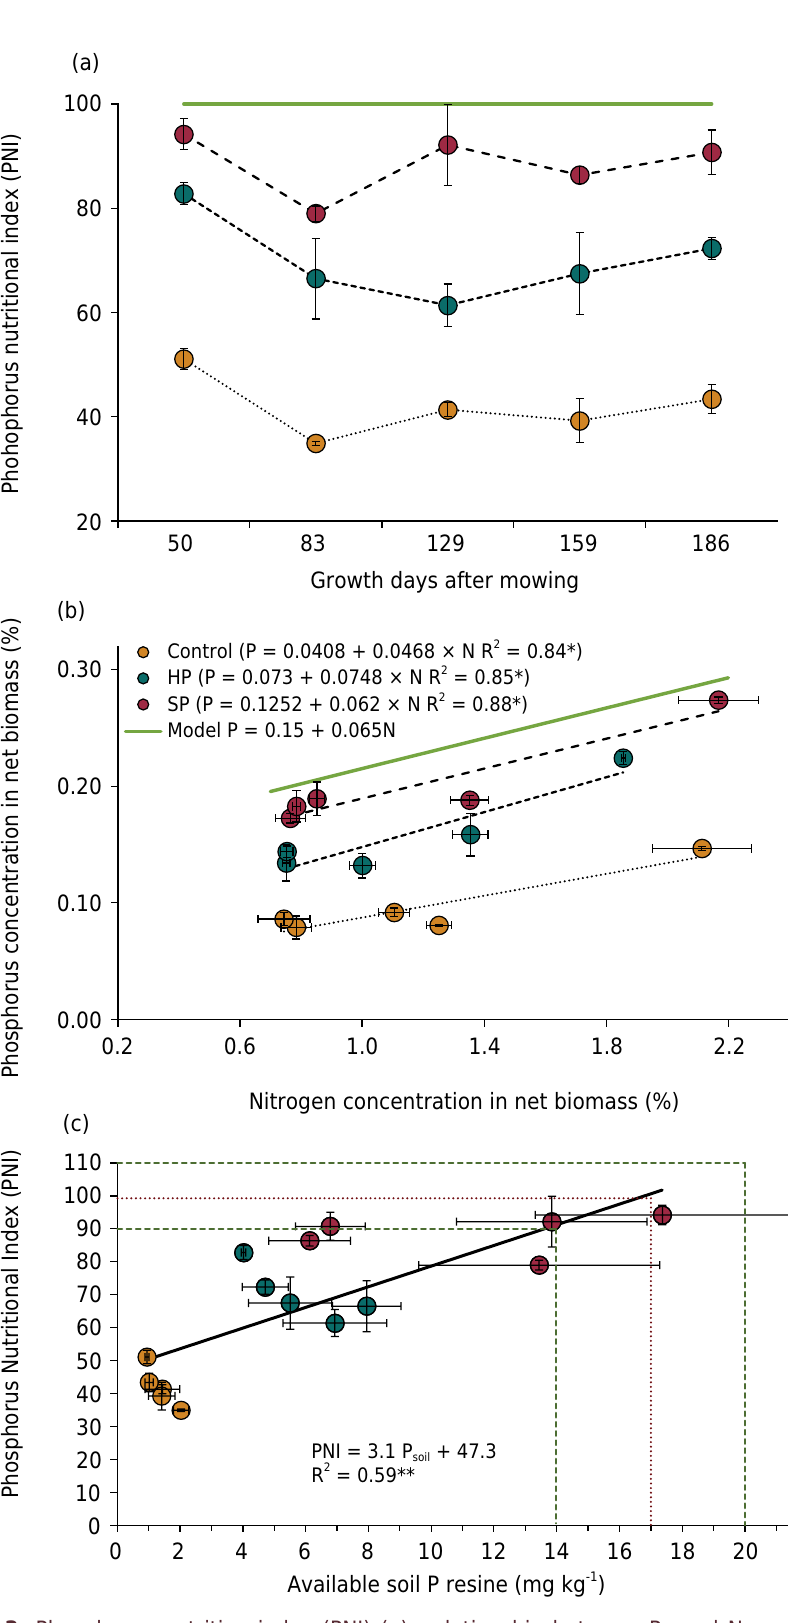
Figure 3. Phosphorus nutrition index (PNI) (a); relationship between Ps and N content in dry matter (b), relationship between available P and PNI (c) in a natural grassland from Southern Brazil with the application of different P sources. Control: without P addition; HP: hyperphosphate; SP: superphosphate. Model: model suggested by Duru and Thelier-Huche